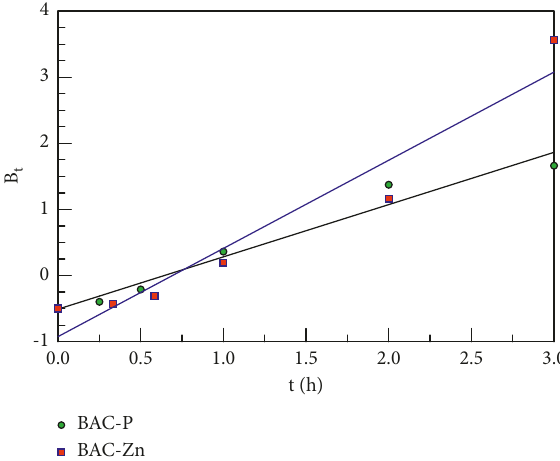
Figure 17: Intraparticle diffusion kinetics for adsorption of 1g L − 1 Cu(II) ions onto the BAC-P and BAC-Zn adsorbents.